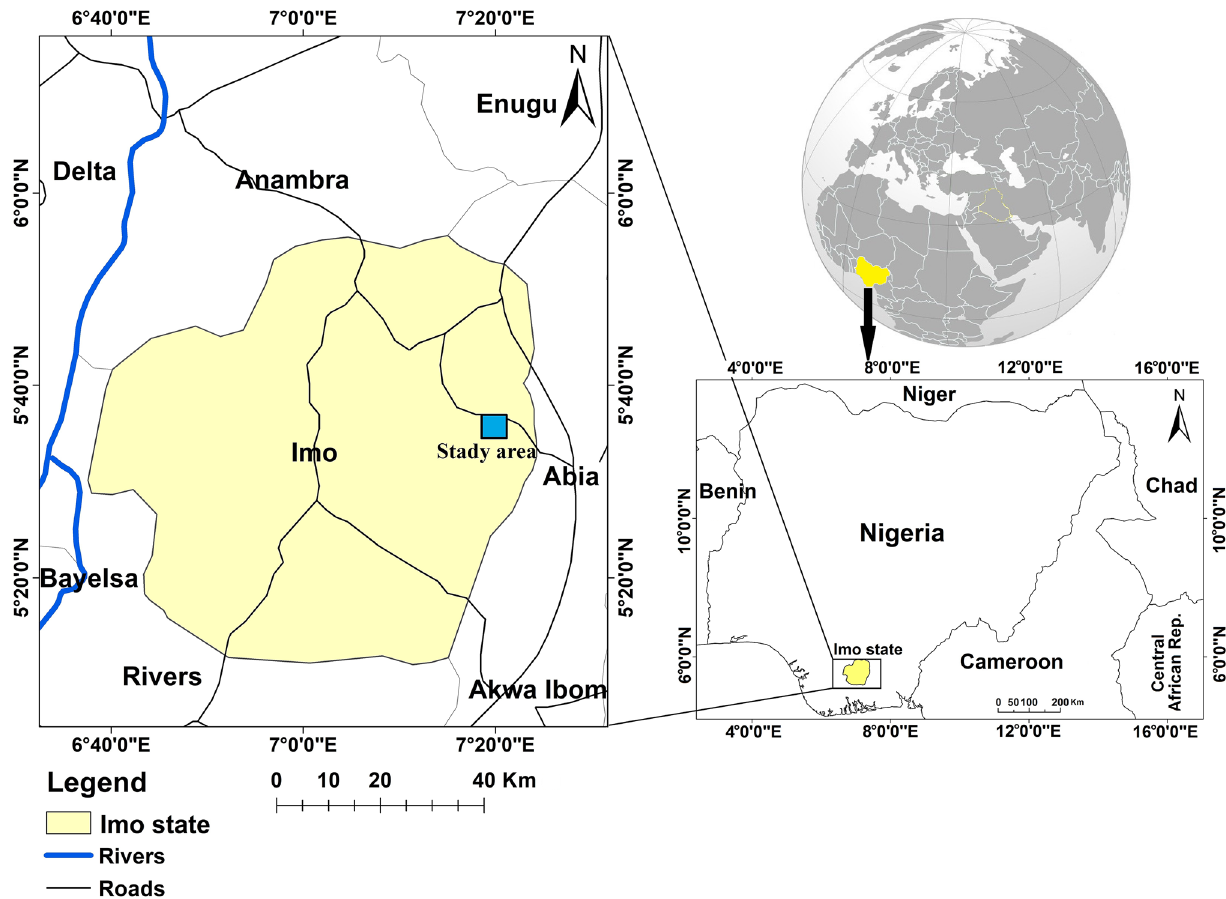
Fig. 1 Location of the study